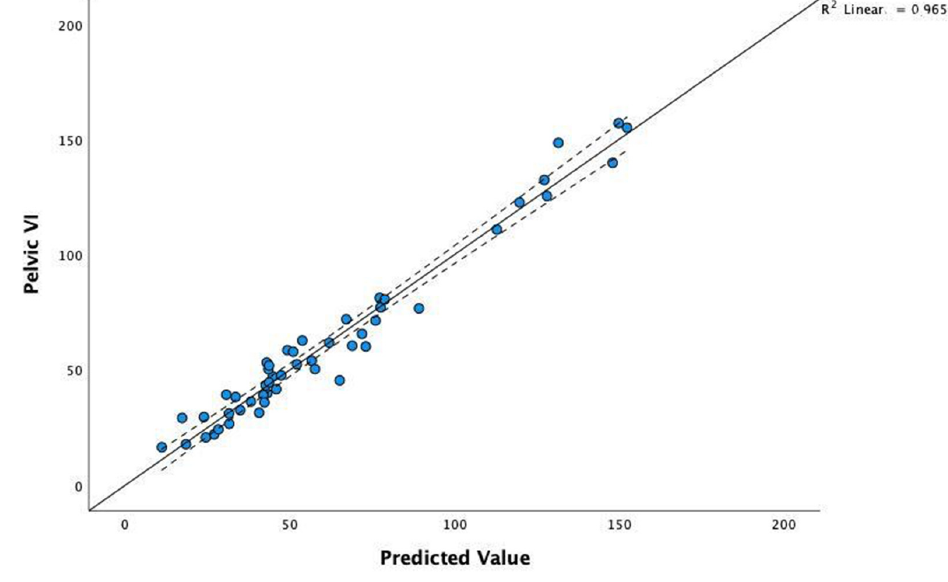
Figure 5. Correlation scatterplot of pelvic VI for the observed values and those predicted by the model.